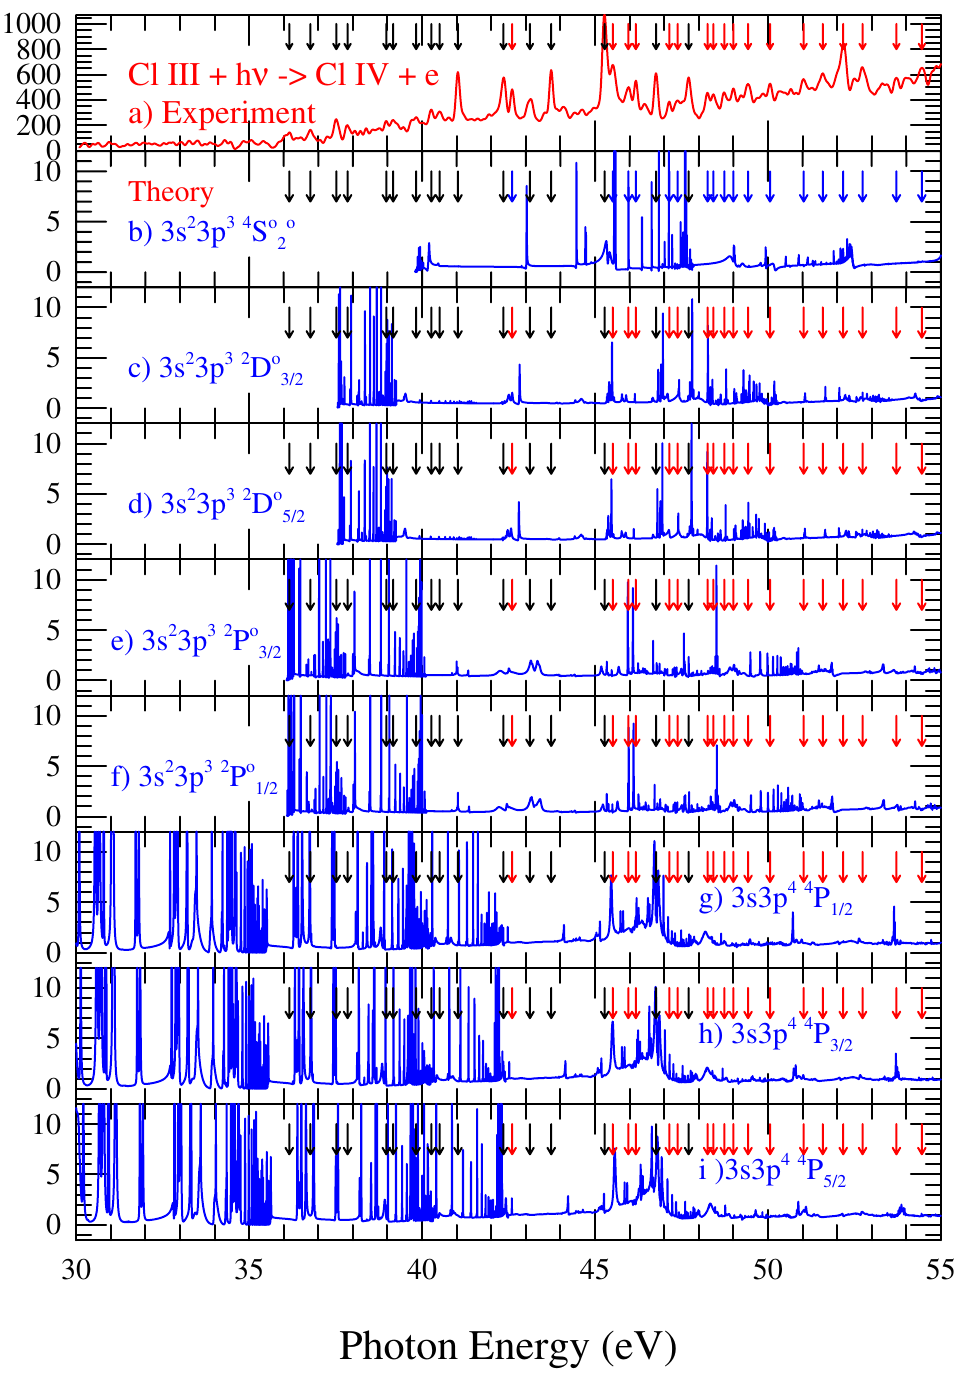
Figure 2. (Color online) Calculated single-photon photoionization ion-yield spectrum of Cl III into Cl IV (blue) in panels ( b – i ). The top panel (red) corresponds to the measured spectrum of Figure 1. ) and Subsequent panels present the σ PI of the eight lowest levels of Cl III, ground ( b ) 3 s 2 3 p 3 ( 4 S o 3/2 ) , ( d ) 3 s 2 3 p 3 ( 2 D o ) , ( e ) 3 s 2 3 p 3 ( 2 P o ) , ( f ) 3 s 2 3 p 3 ( 2 P o ) , ( g ) 3 s 3 p 4 ( 4 P ) , excited ( c ) 3 s 2 3 p 3 ( 2 D o 5/2 5/2 3/2 3/2 1/2 ( h ) 3 s 3 p 4 ( 4 P 3/2 ) , ( i ) 3 s 3 p 4 ( 4 P 1/2 ) . The first five levels ( b – f ) show contributions to the observed spectrum by the presence of resonant structures while the three excited levels of 3 s 3 p 4 ( 4 P ) ( g – i ) show lesser